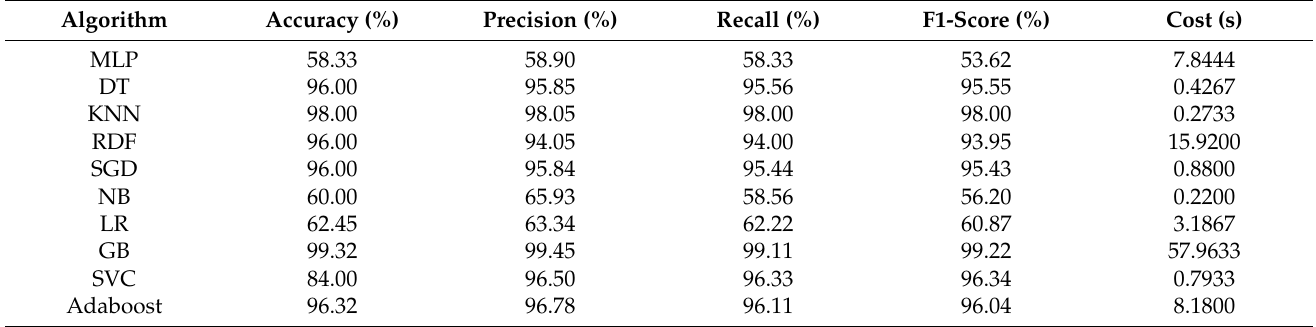
Table 12. Global performance comparison of ML models using combination of (RS) and (Z) features.